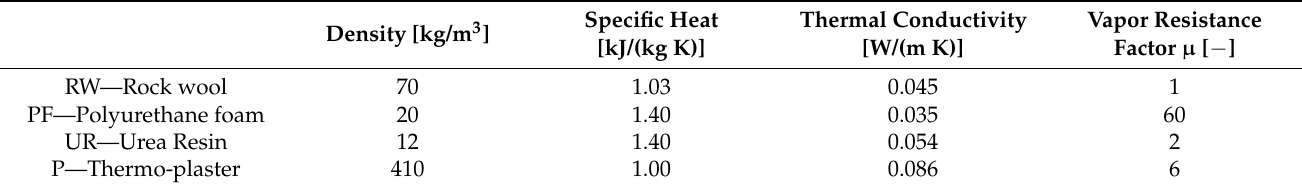
Table 7. Main features of the filling